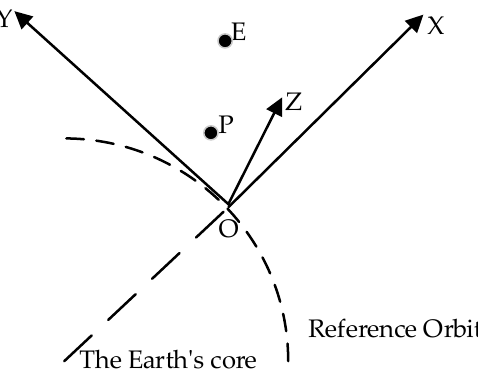
Figure 1. The local-vertical local-horizontal (LVLH) coordinate